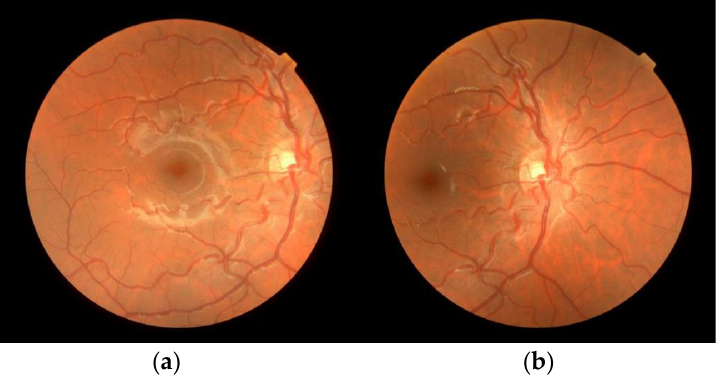
Table 3. Retinography labels according to subject, eye, and frame center.